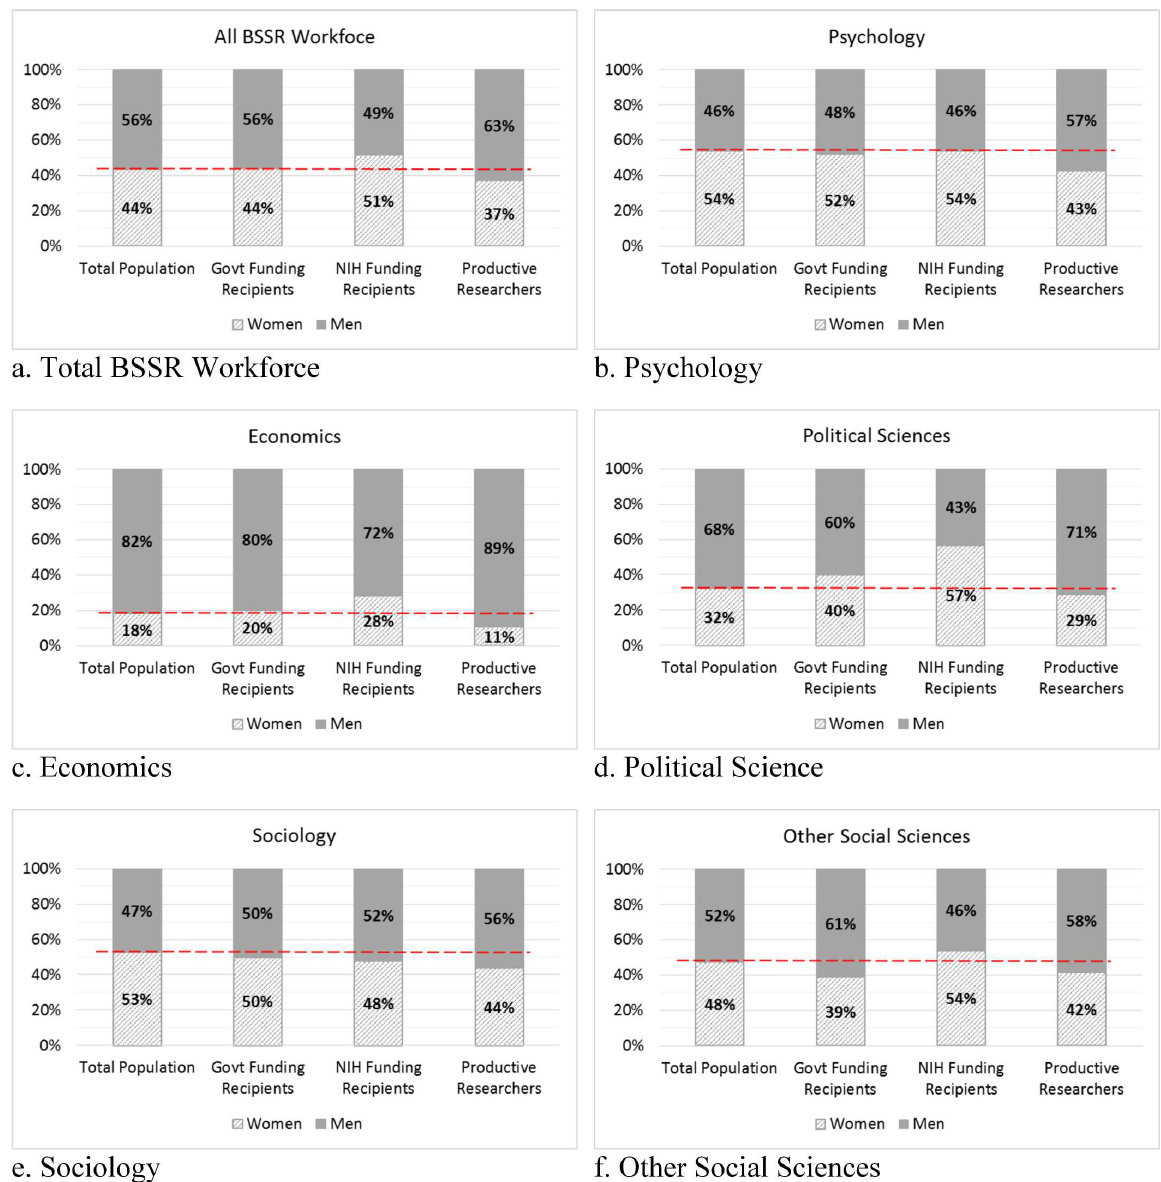
Fig 2. Gender distribution by major field. Source: SDR 2008 and